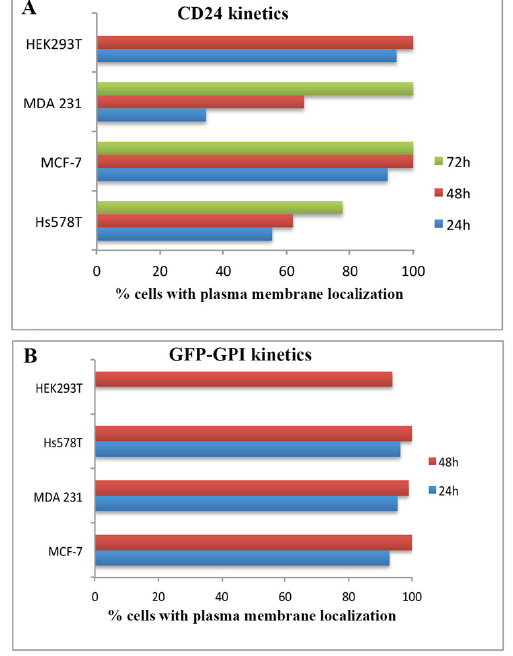
Figure 3. Kinetics of ER-tag CD24 ( A ) and GFP-GPI ( B ) in HEK293T and breast cancer cell lines . Diagrams show percentage of cells with plasma membrane localization independently of presence or not of ER-tag CD24 or GFP-GPI at cytoplasmic locations. Statistical analysis is presented in Table